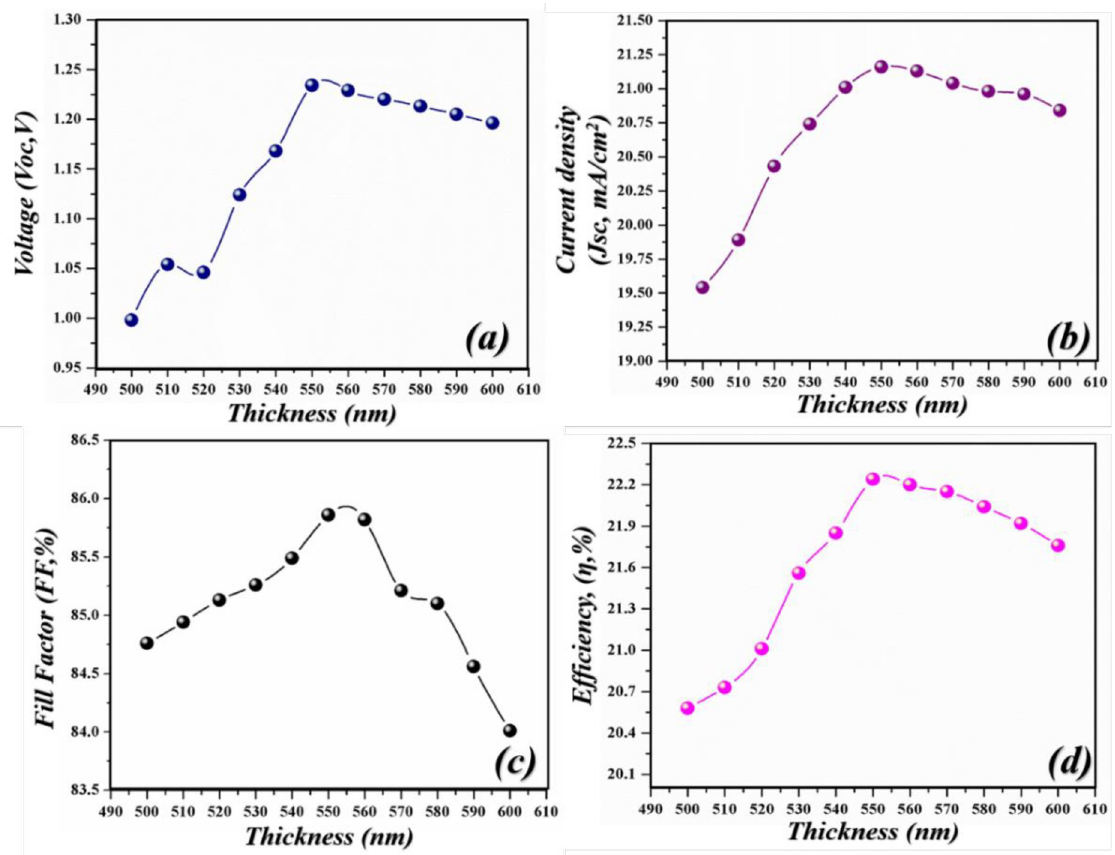
Fig 7. Simulated photovoltaic parameters of novel geometry (a) V oc as an independent function of light-harvesting layer, (b) J sc as an independent function of the light-harvesting layer (c) FF as an independent function of light-harvesting layer (d) PCE as an independent function of light-harvesting